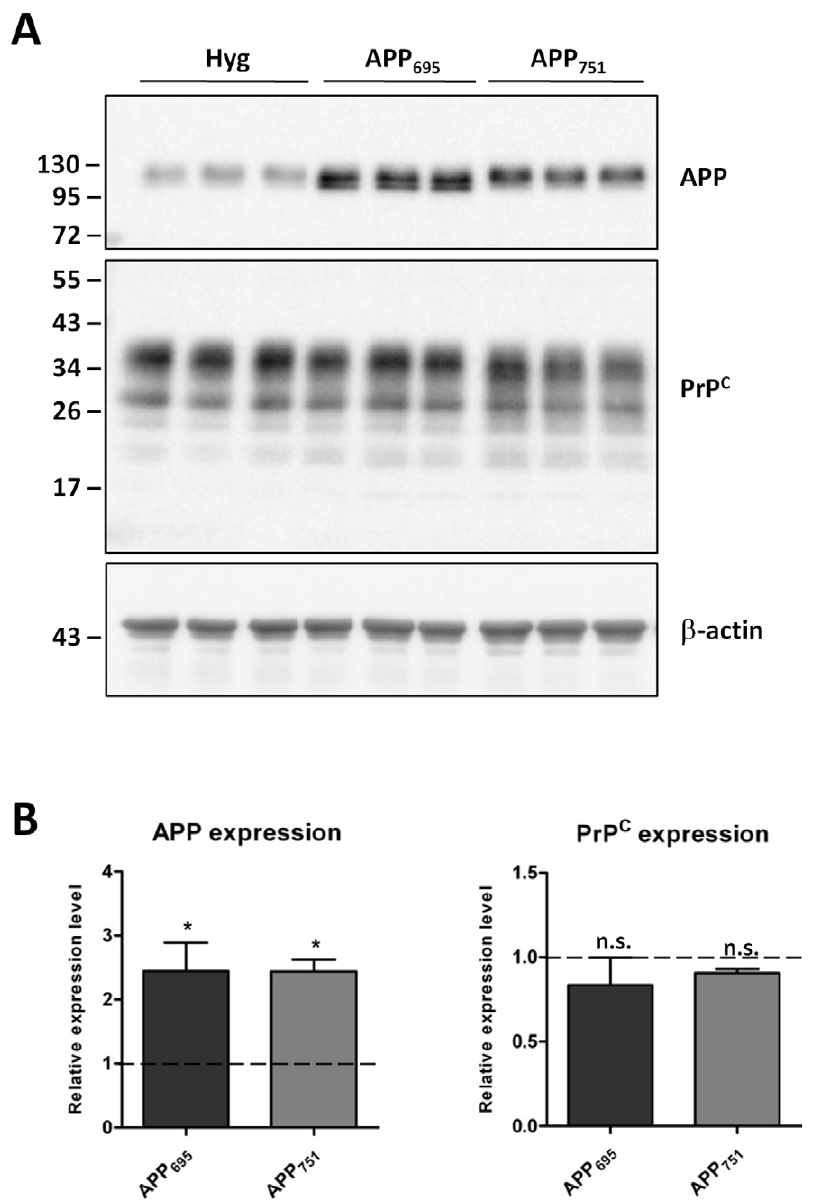
Figure 2. Over-expression of APP isoforms in N2a cells does not alter endogenous PrP C . (A) Representative western blot of APP and PrP C (antibody 6H4) in N2a cells stably transfected with either the vector alone (Hyg) or one of the APP isoforms (APP 695 , APP 751 ), and subsequent b -actin staining. Approximate molecular weights (kDa) are indicated. (B) Quantification of APP and PrP C protein levels expressed relative to Hyg control cells (dashed line). Data from 3 independent experiments. Statistical analysis by one way ANOVA with Dunnett’s post test comparison to the Hyg cells, *p , 0.05, n.s. not significant.